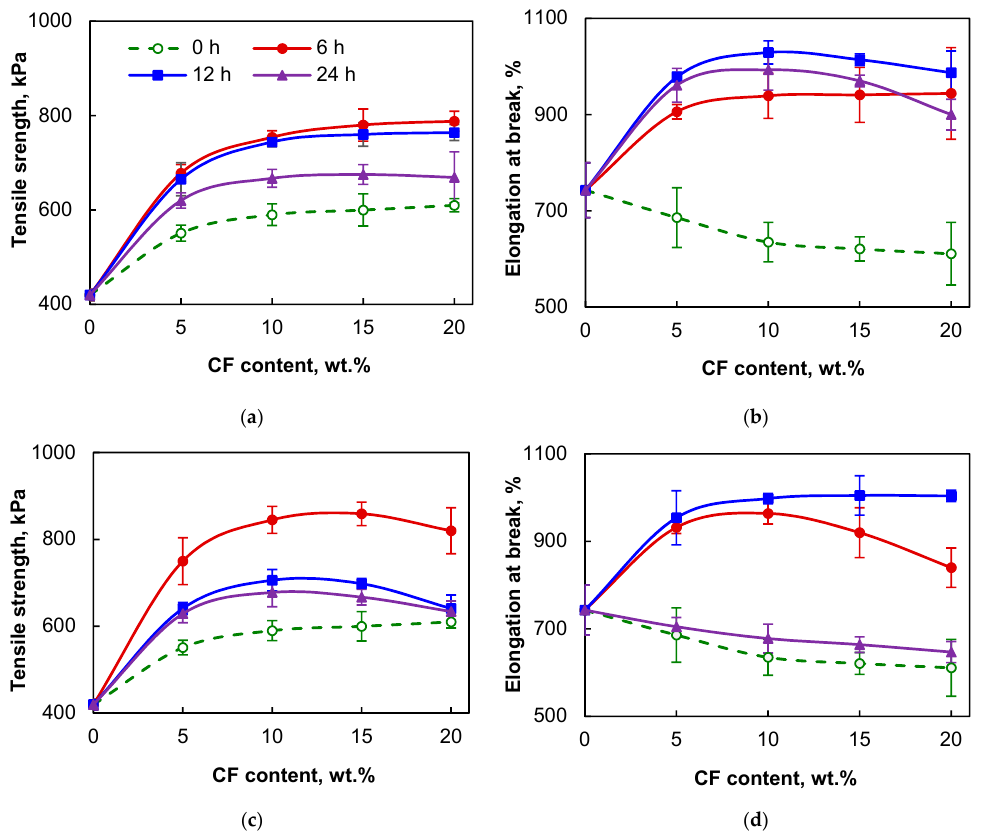
Figure 16. Dependence of PDMS / CF composites’ tensile strength ( a , c ) and elongation at break ( b , d ) upon CF content, treatment time and mode: ( a , b ) CFvap; ( c , d ) CFliq.